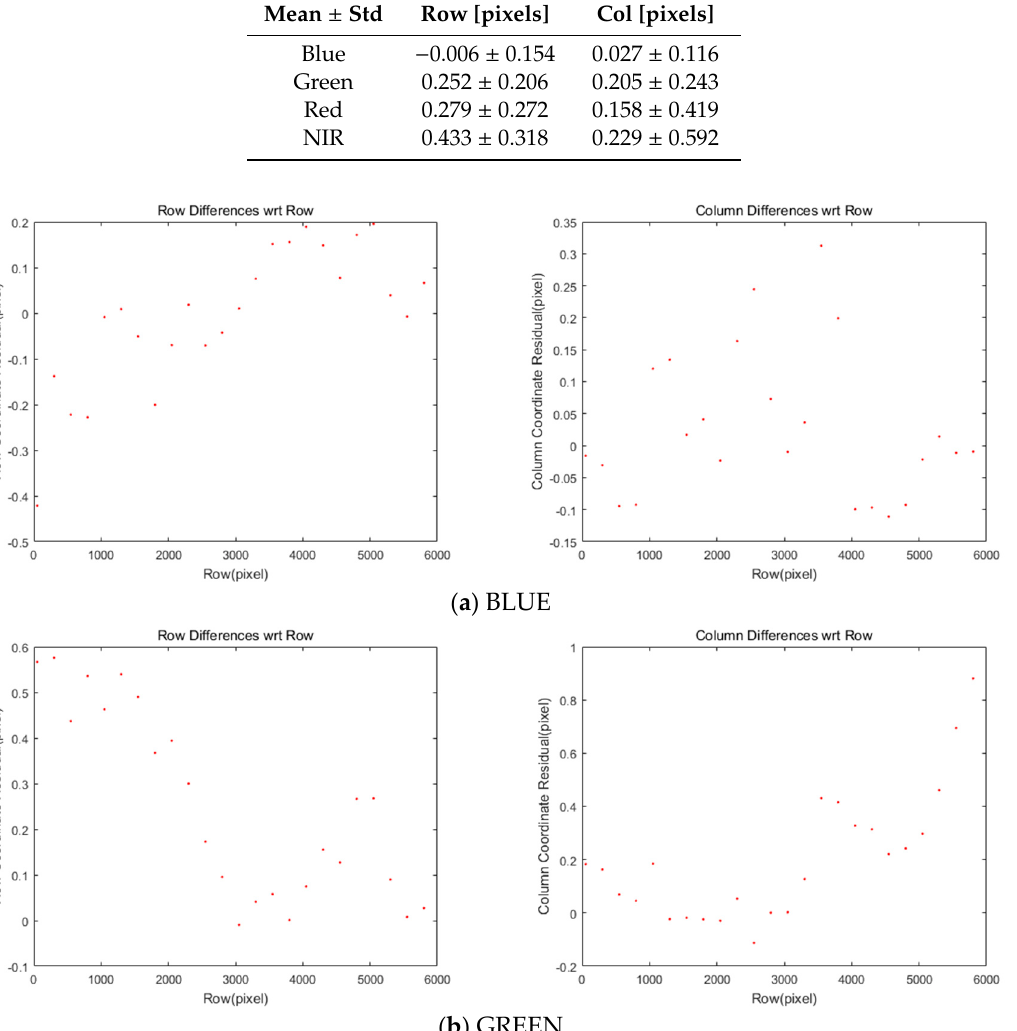
Table 3. Estimated parameters of the coordinate differences due to the initial CCD offsets.